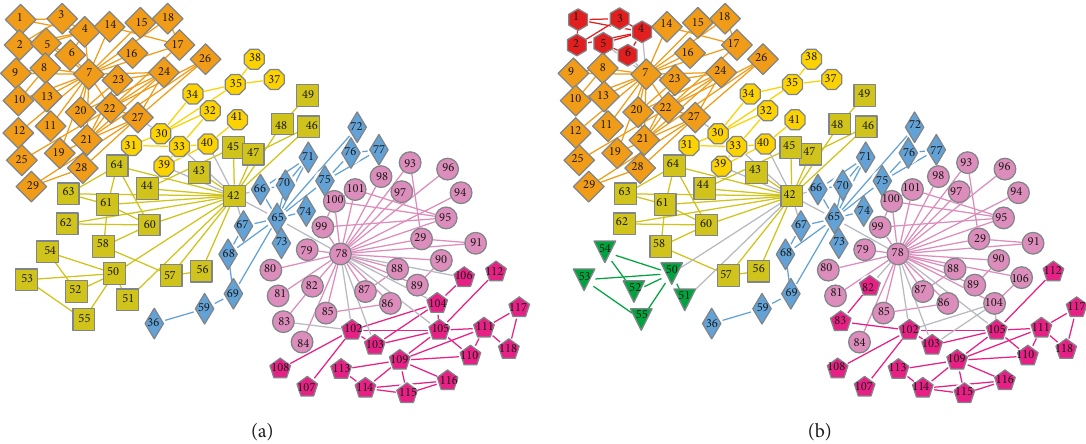
Figure 7: The collaboration network of scientists working at the Santa Fe Institute . (a) The ground-truth community structure. (b) The community structure detected by our proposed NSA algorithm.